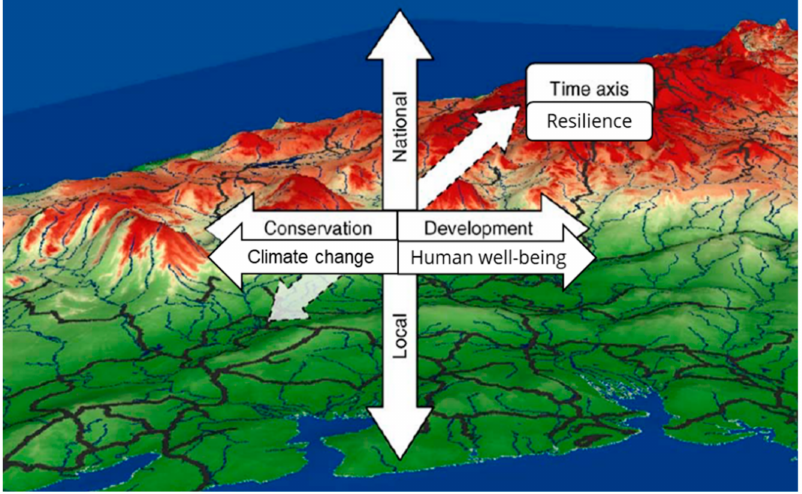
Figure 4. The objectives of Integrated Landscape Approaches (Source: Modified from Pfund